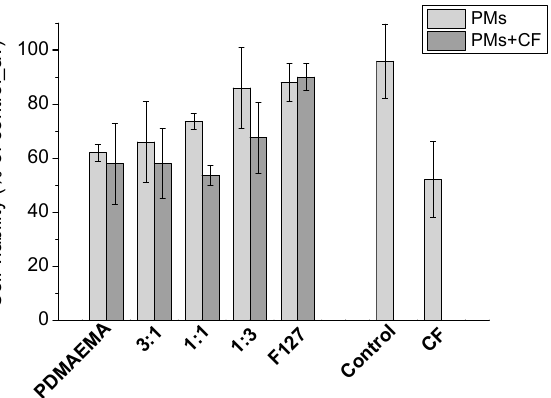
Figure 7. Cytotoxicity of SCPMs and MPMs based on PDMAEMA-b-PCL-b-PDMAEMA and Pluronic F127 triblock copolymers on HSF cells.